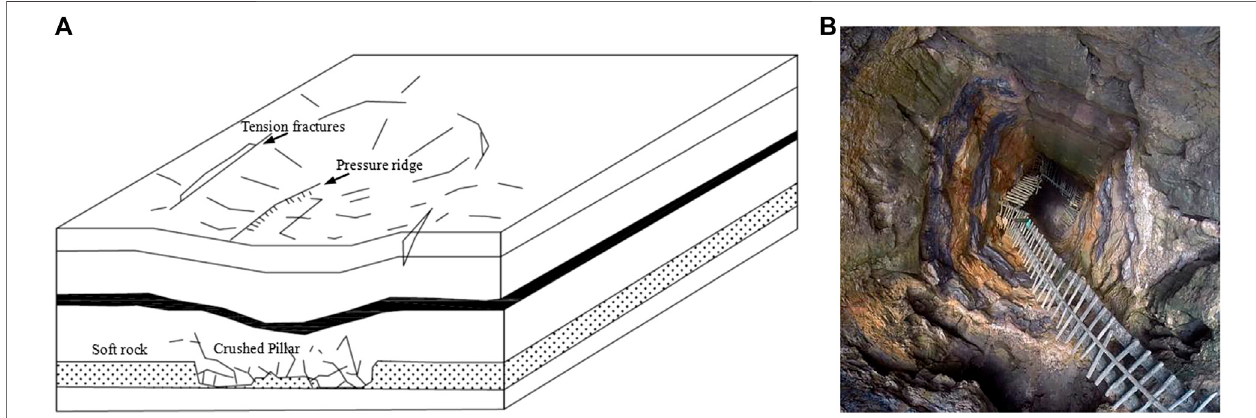
FIGURE 1 | Typical sag subsidence con fi guration: (A) the ground surface subsidence due to themine layout and the geology conditions (Bell and de Bruyn,1999), (B) a collapse of mine with interbedding structure in Meghalaya main shaft, India (Schneider, 2014).